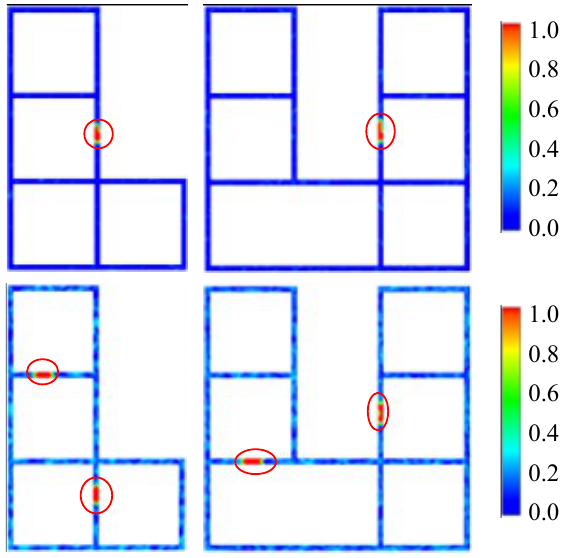
Figure 8. The result of corrosion diagnosis on L-shape and U-shape block.